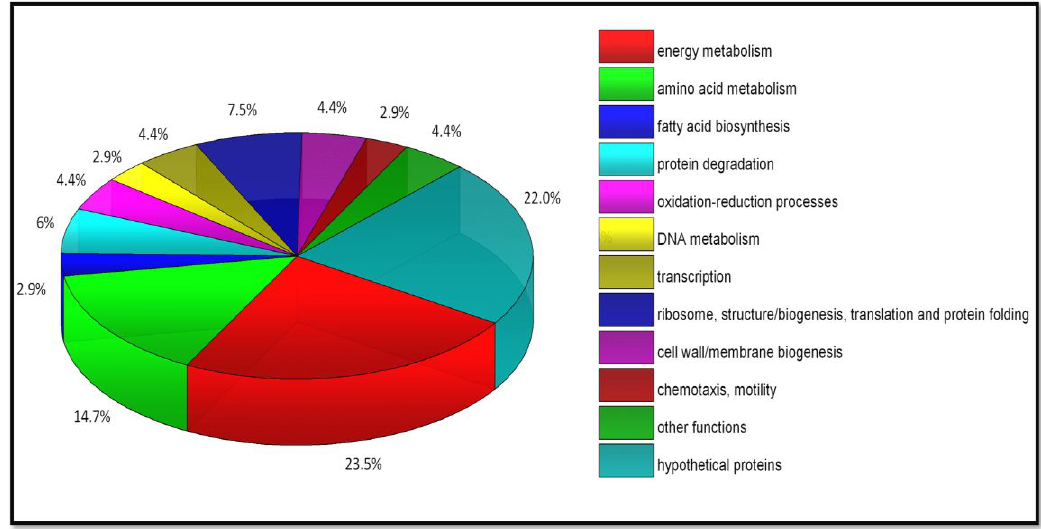
Figure 2. Functional classification of putative protein substrates of L. interrogans ClpB. The pie chart was created using the OriginLab software (OriginPro2016, Northampton, MA, USA) and shows the percentage distribution of the identified ClpB-interacting proteins among different biological processes [70].